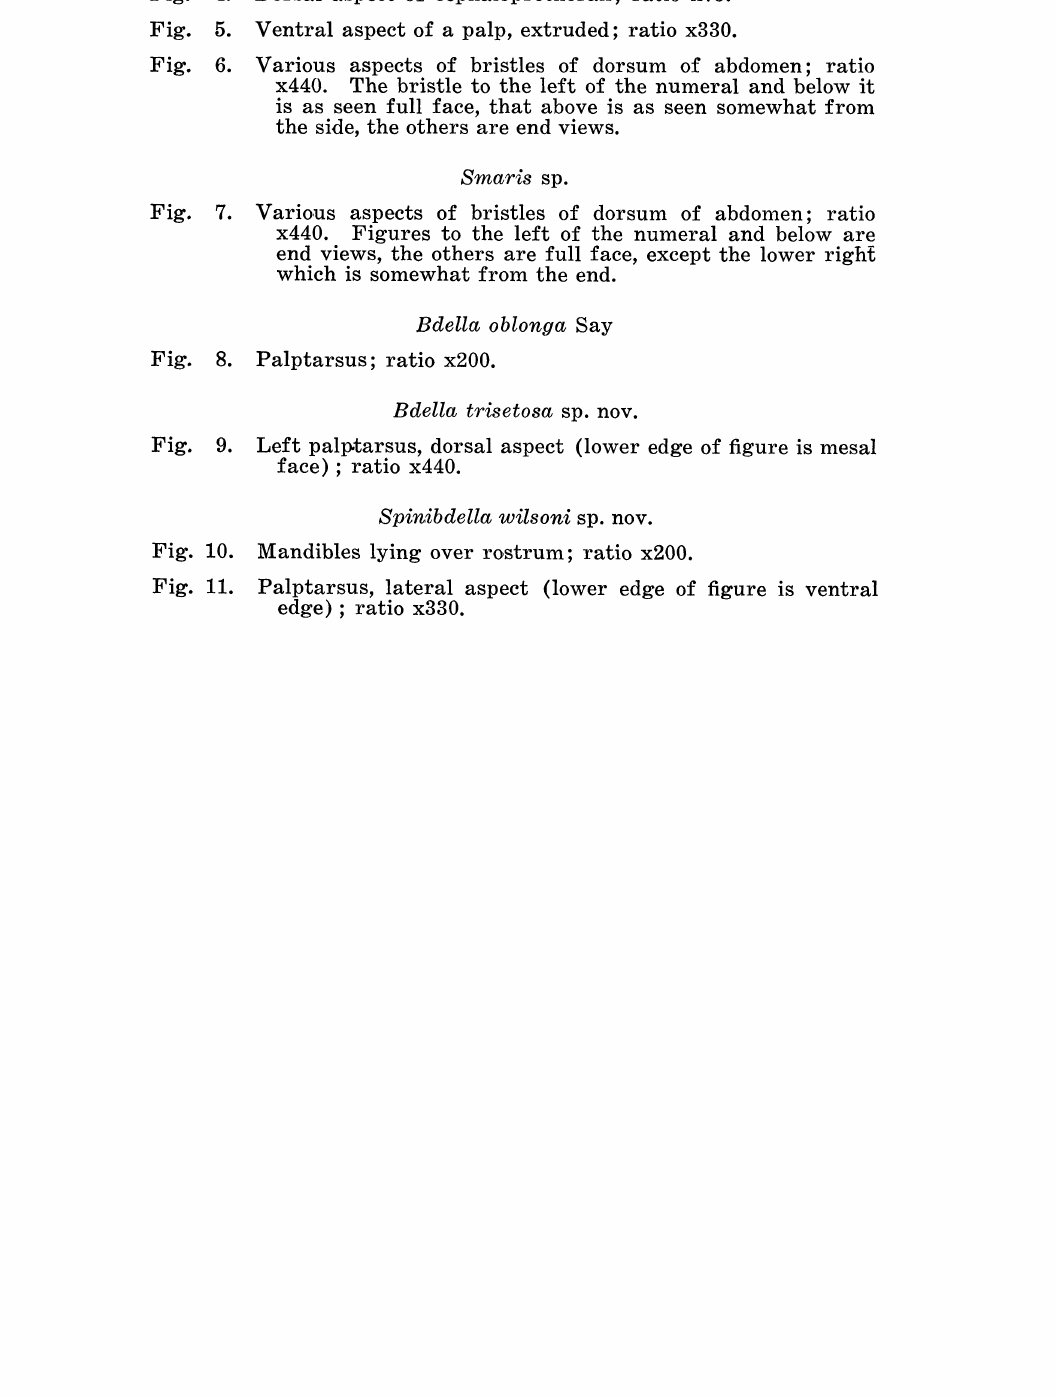
Dorsal aspect of cephalopro.thorax; ratio x75. Ventral aspect of a palp, extruded; ratio